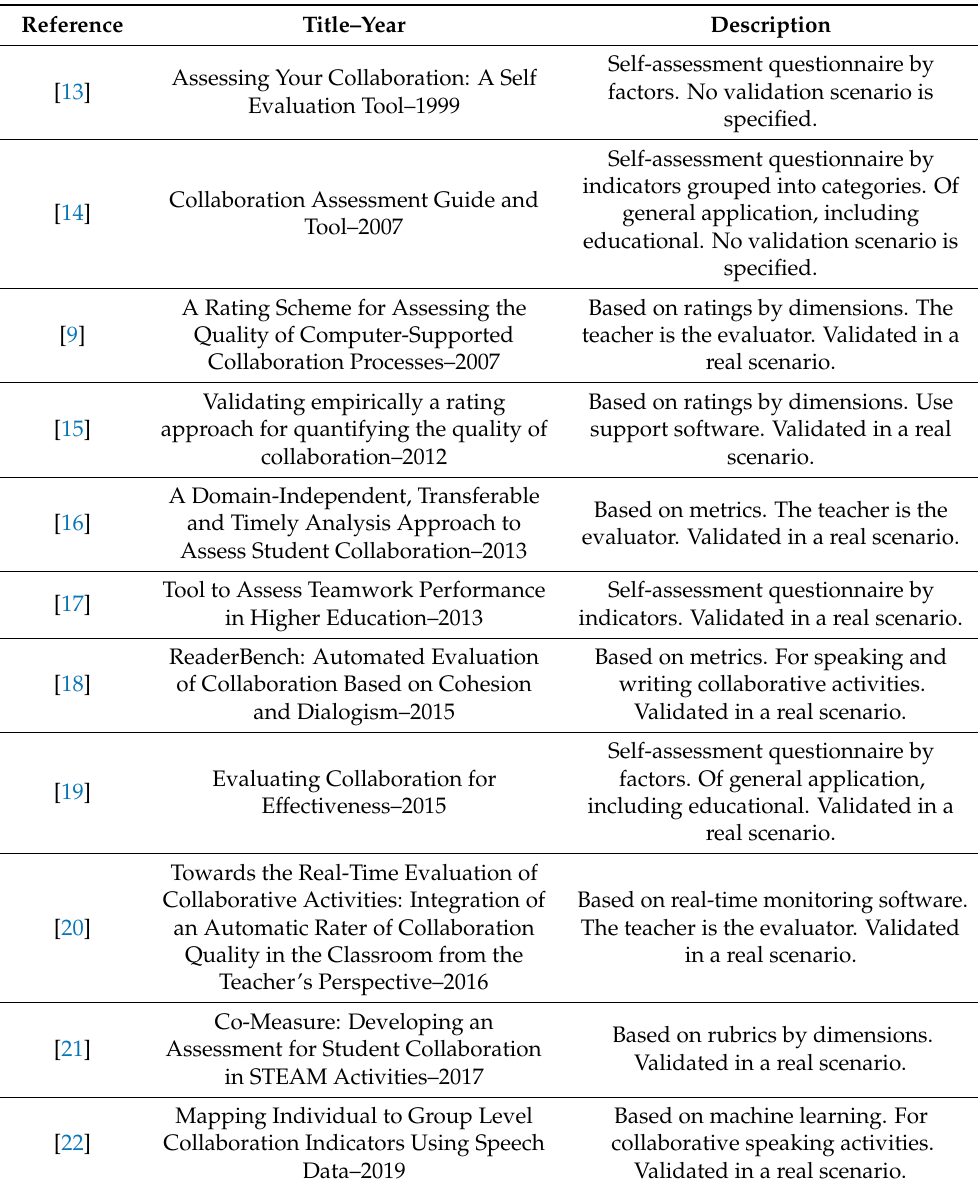
Table 1. Studies on the evaluation of collaboration in the last